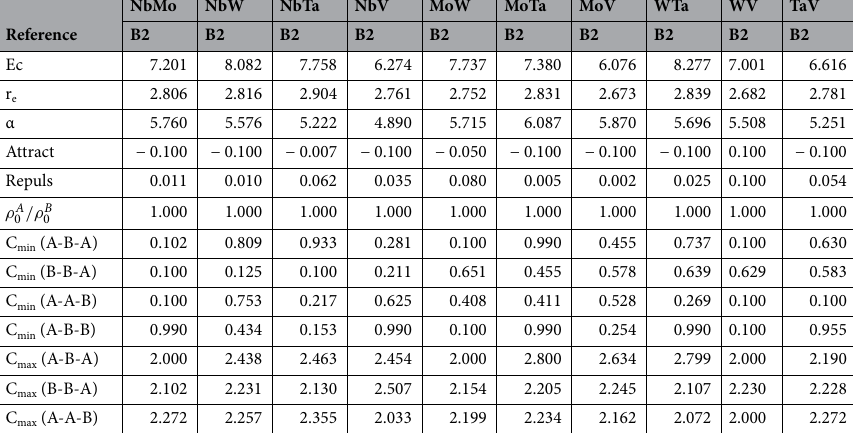
Table 2. The cross-element parameters of 2NN MEAM potential for Nb, Mo, T, W, and V atoms in the LAMMPS format.